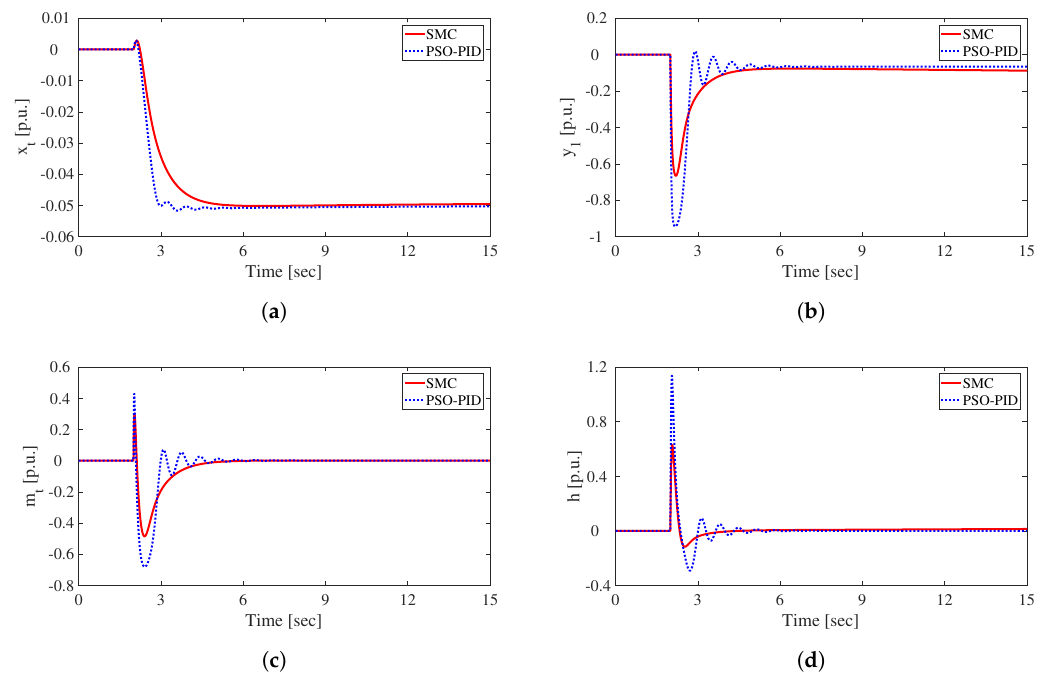
Figure 3. The time waveforms of ( a ) x t ; ( b ) y 1 ; ( c ) m t ; and ( d ) h under target speed